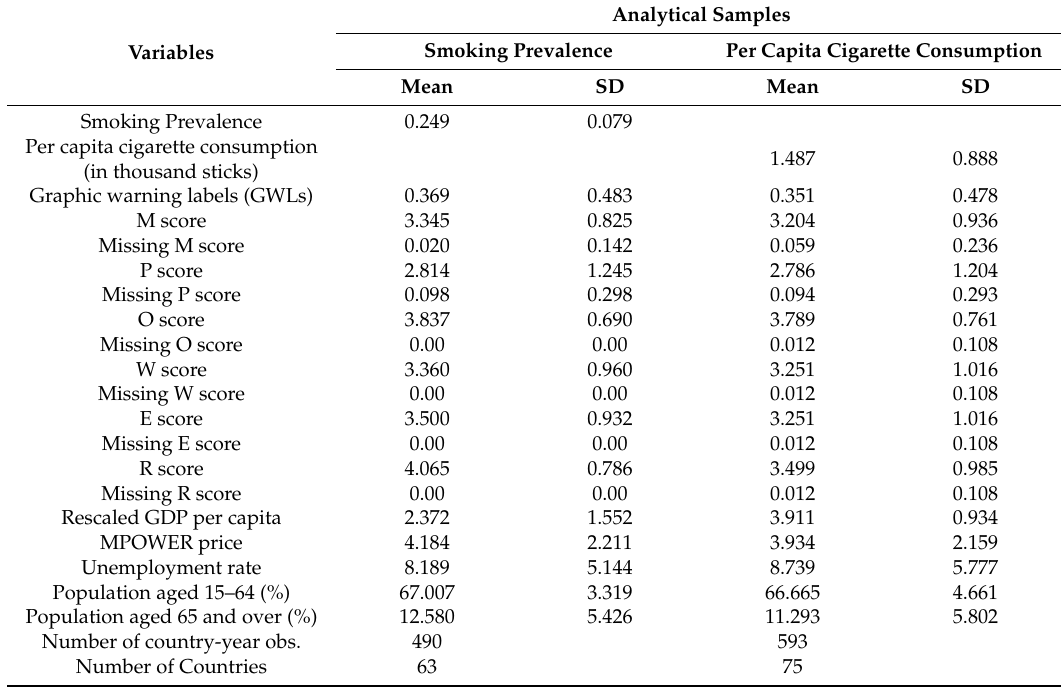
Table 1. Summary statistics